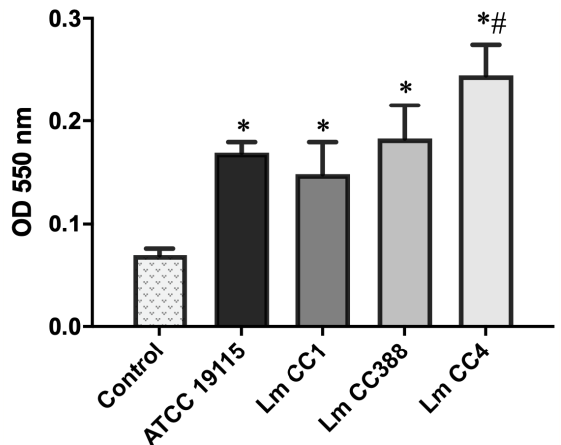
Figure 3. Hemolytic activity of L. monocytogenes . Hemolysis of murine erythrocytes after 4 h of incubation with L. monocytogenes Lm CC388, Lm CC1, Lm CC4 and ATCC 19115 strains. Data are the means of 3 different assays. *: p < 0.05 versus control, #: p < 0.05 versus ATCC 19115 or Lm CC1.